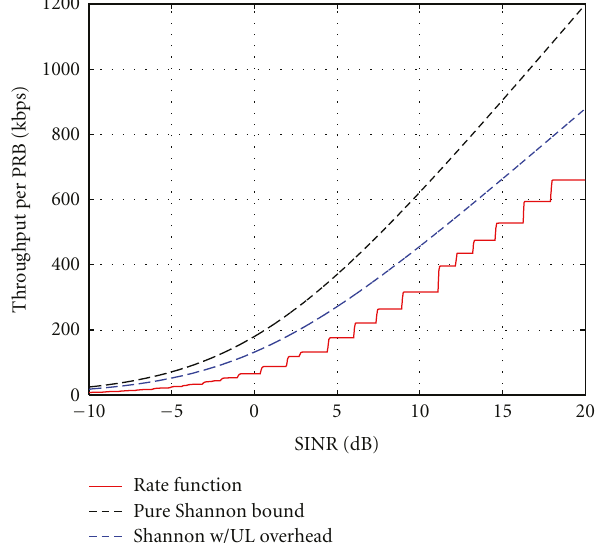
Figure 1: Rate function for the